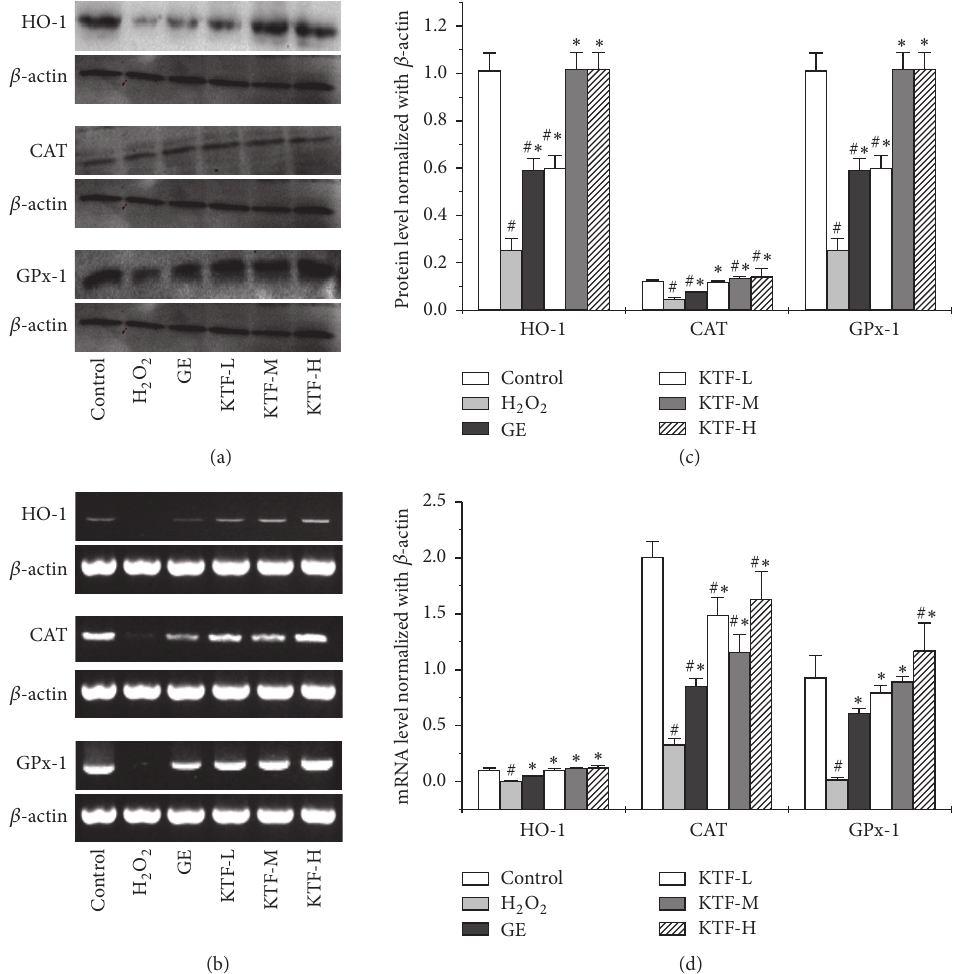
Figure 6: KTF increased the protein and mRNA expression of antioxidant enzymes in H 2 O 2 -induced MES23.5 cells. (a) The protein expressions of HO-1, CAT, and GPx-1 were determined with Western blot and quantified in (c). (b) The mRNA expressions of HO-1, CAT, and GPx-1 were determined with RT-PCR and quantified in (d). Data are expressed as mean ± SD in three independent experiments. # 𝑃 < 0.05 compared to the control group. ∗ 𝑃 < 0.05 compared to the H 2 O 2 -treat